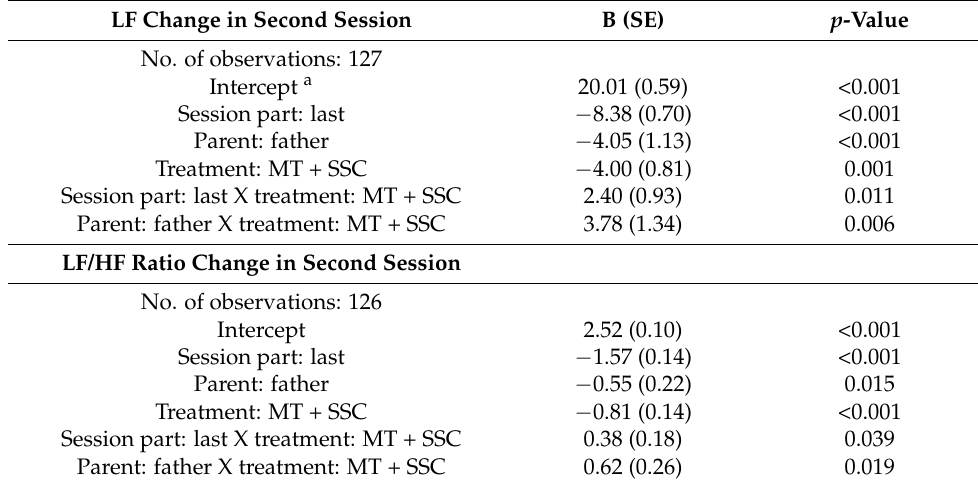
Table 4. Linear mixed effects models of secondary outcomes in the second